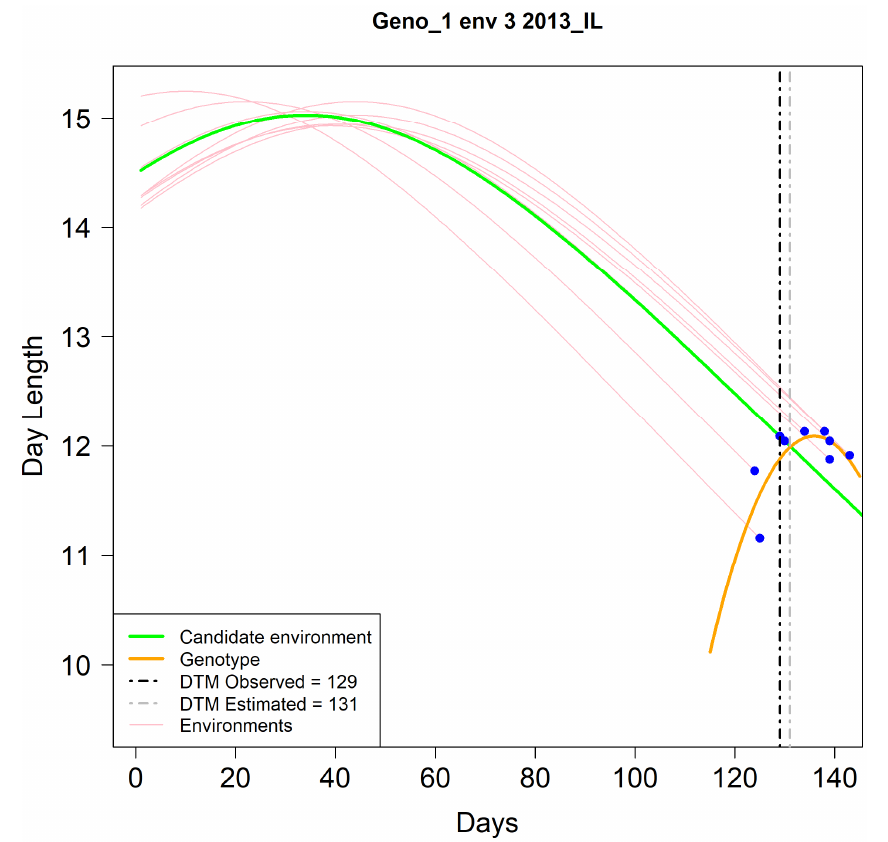
Figure 2. Graphical representation of the C-method for estimating DTM for genotype 1 (Geno_1) in the 2013 Illinois environment (IL_2013). The green line represents the candidate (targeted) unobserved environment, and the orange line shows the response gradient of genotype Geno_1 across all observed environments. The blue dots represent the daylength value at the R8 occurrence in each environment. The observed DTM was 129 days compared to the estimated value of 131 days. Geno_1 was observed in 10 environments total; thus, 9 of these were used for model fitting (orange line) to estimate the DTM in